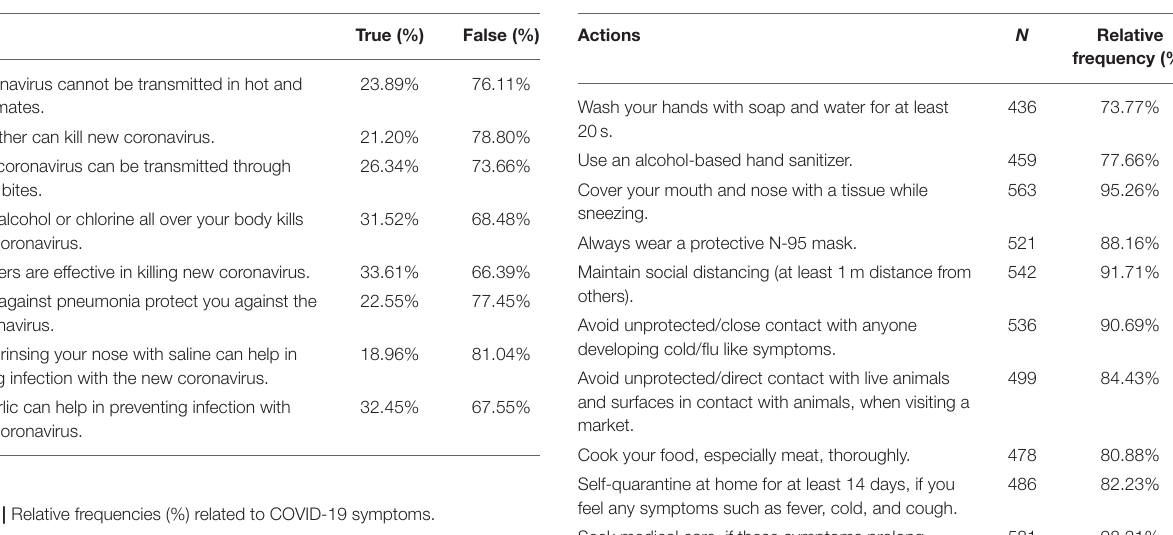
TABLE 3 | Relative frequencies (%) related to COVID-19 symptoms. Symptoms